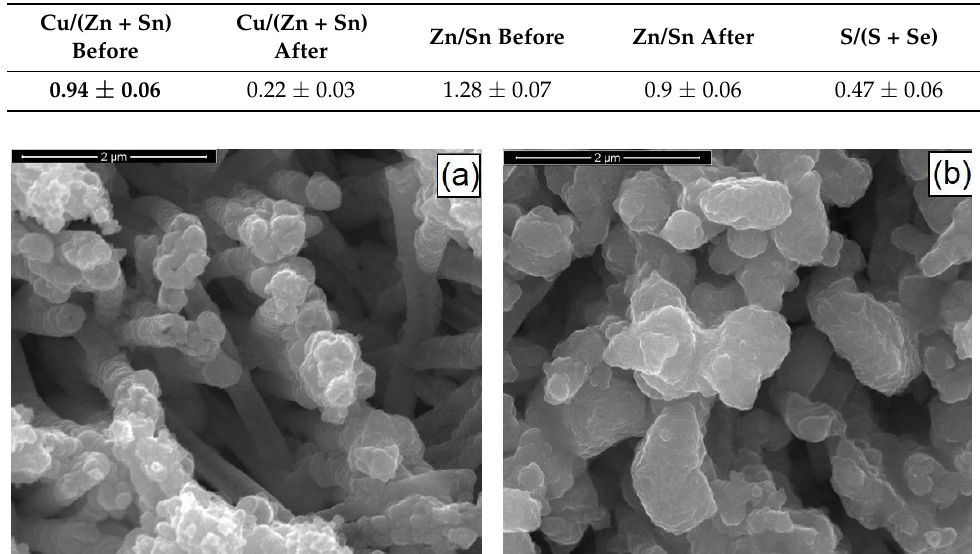
Table 3. Cu/(Zn + Sn) and S/(S + Se) ratios before and after annealing. NWs were obtained at pH = 3 with a copper content of 1 mM.